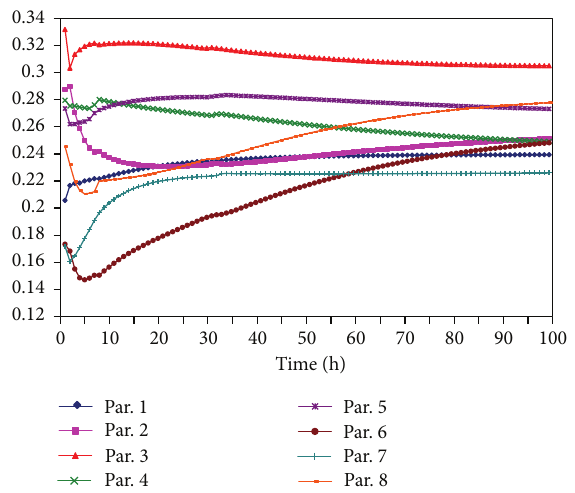
F 15: Empirical correlation ratios (peak fuel temperature) variations versus time for the 200 LHS Normal